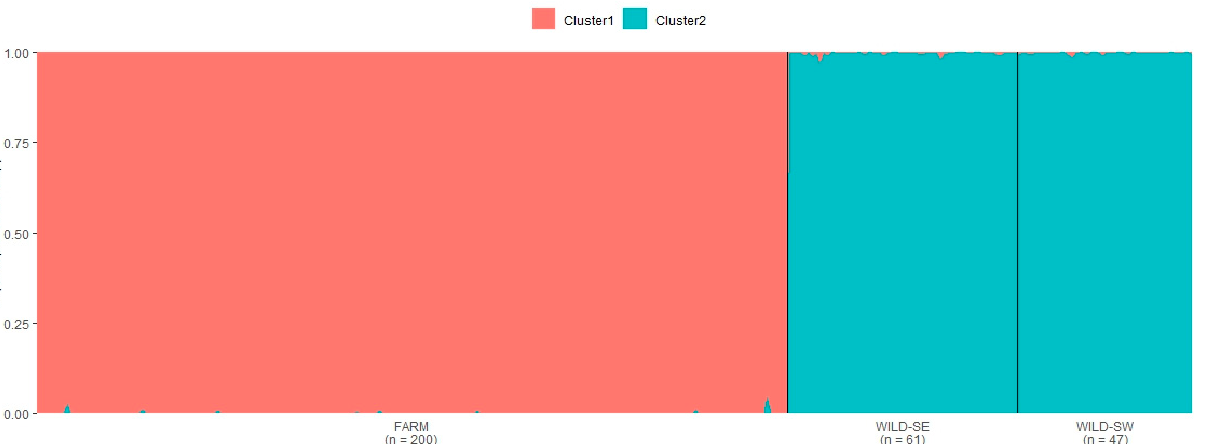
Figure 3. The Delta K plot showing the highest pick at K = 2 (the most probable number of genetic clusters). The 95% credibility intervals of farm foxes overlapped the 100% assignment to the FARM genetic cluster in all individuals. The same was observed for wild foxes—all 95% credibility intervals overlapped the 100% assignment to the WILD (WILD-SW + WILD-